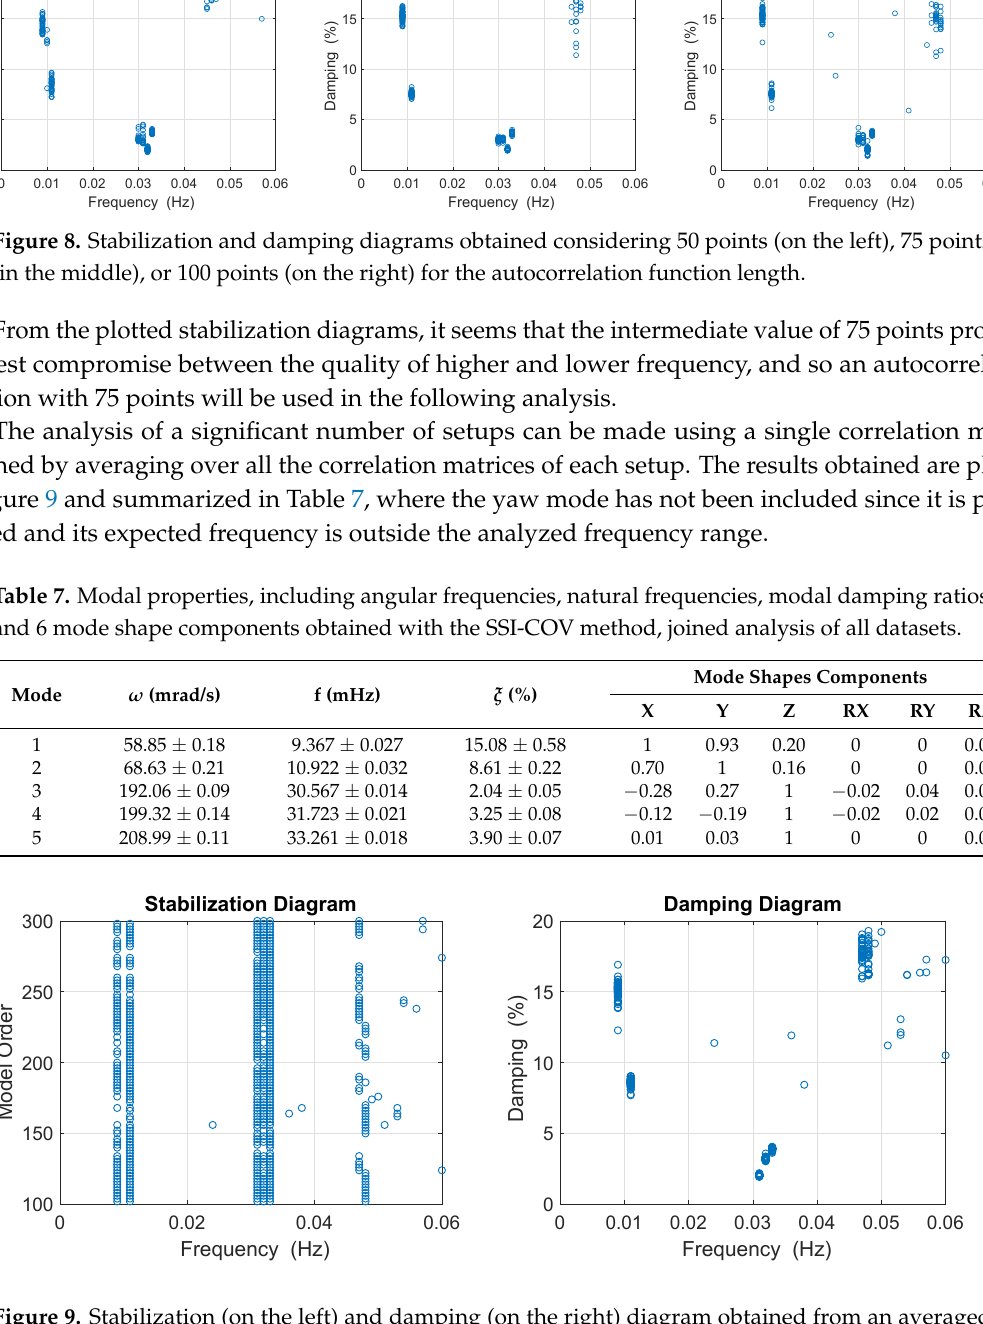
Figure 9. Stabilization (on the left) and damping (on the right) diagram obtained from an averaged autocorrelation